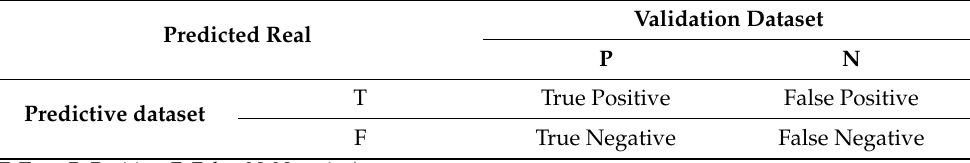
Table 1. Confusion matrix of the classification results.